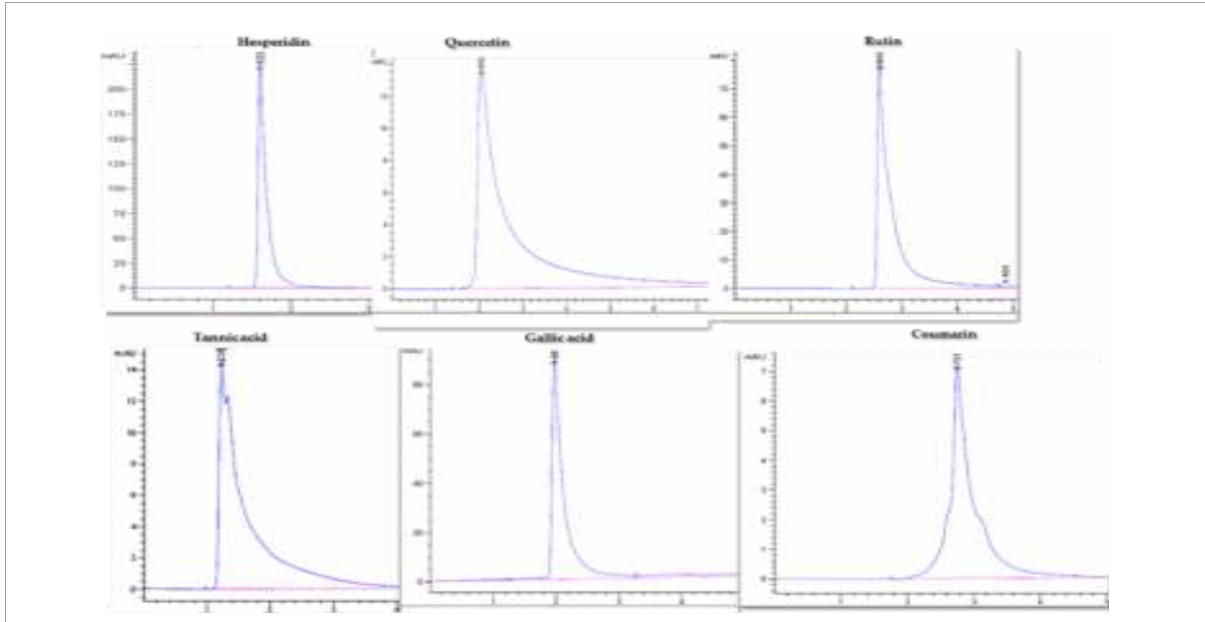
FIGURE1 HPLC chromatograms of hesperidin, quercetin, rutin, tannic acid, gallic acid, and coumarin.